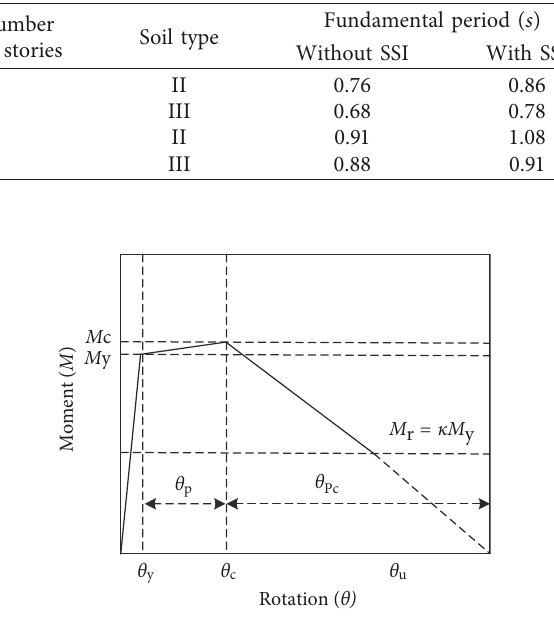
Figure 5: Monotonic moment-rotation relationship for the modified IMK deterioration model [36].